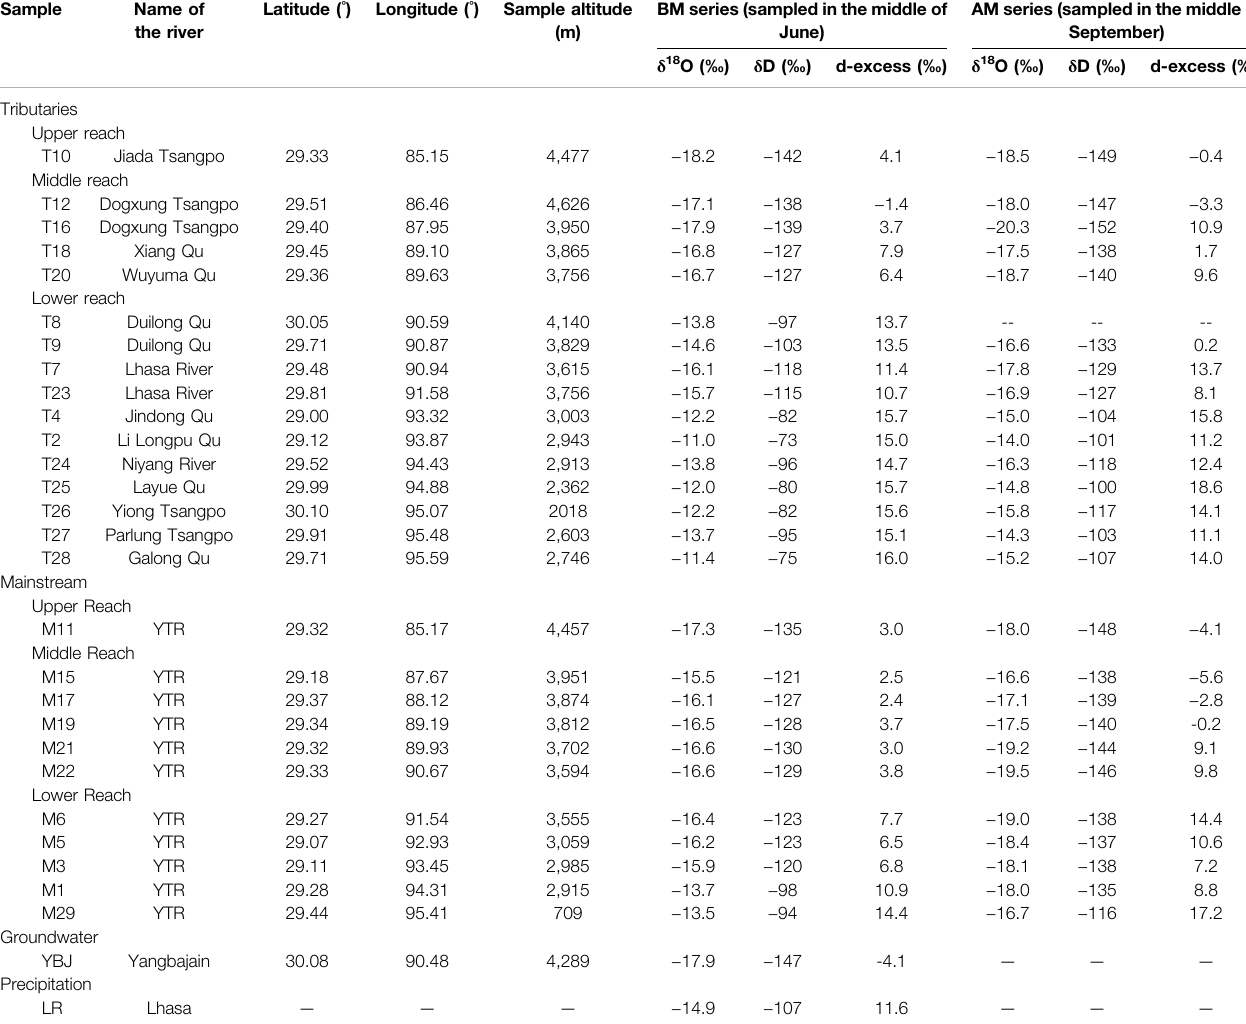
TABLE 1 | Sample locations and stable isotopes compositions. Sample Name of the